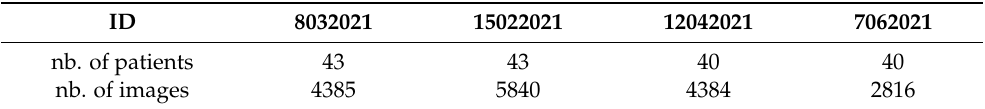
Table 2. The database